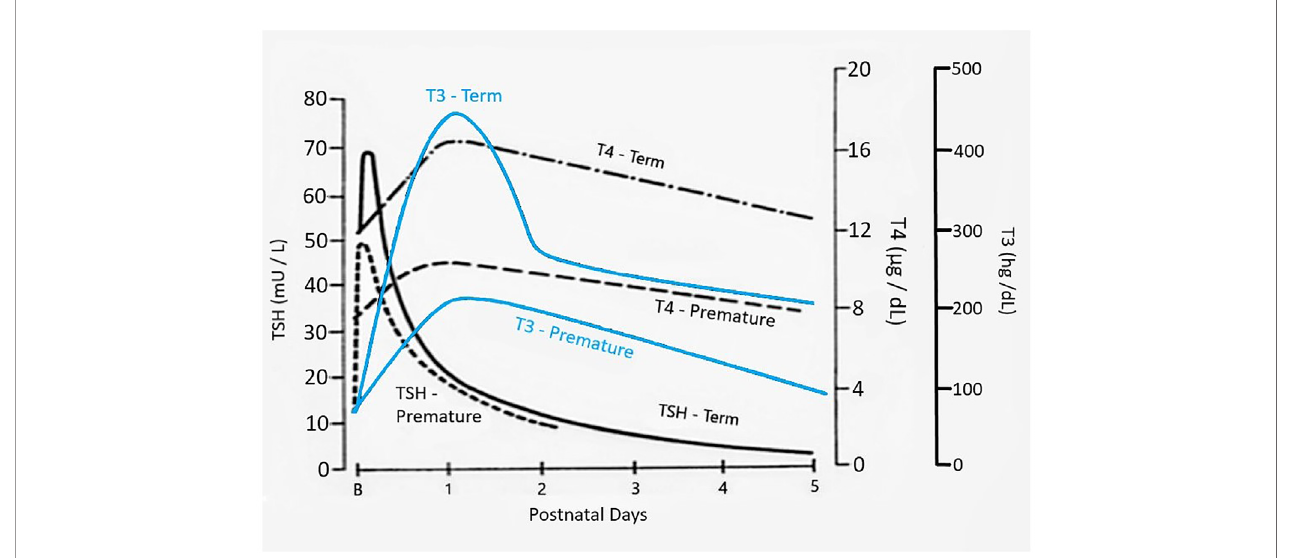
FIGURE 1 | Changes in serum TSH, T4, and T3 following birth in term as compared to preterm newborn infants. Figure developed (with permission) from Fisher DA Thyroid system immaturities in very low birth weight premature infants. Semin Perinatol 2008; 32:387-397.